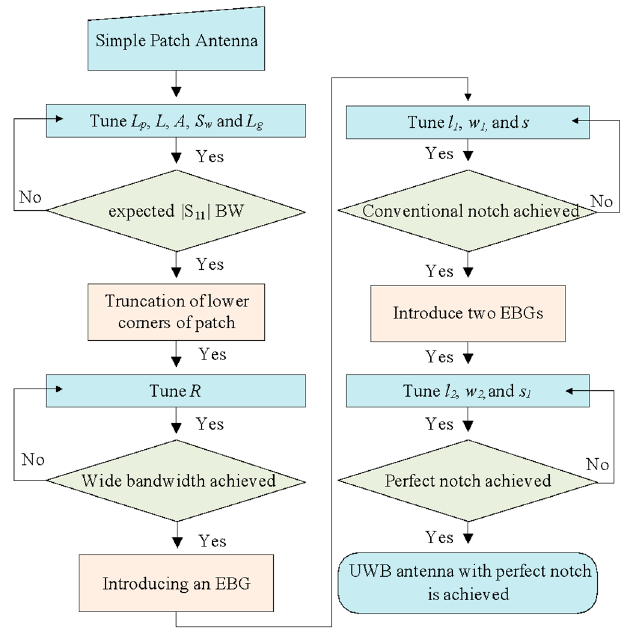
Figure 9. Design procedure of the proposed antenna with rectangular notch-band characteristics.